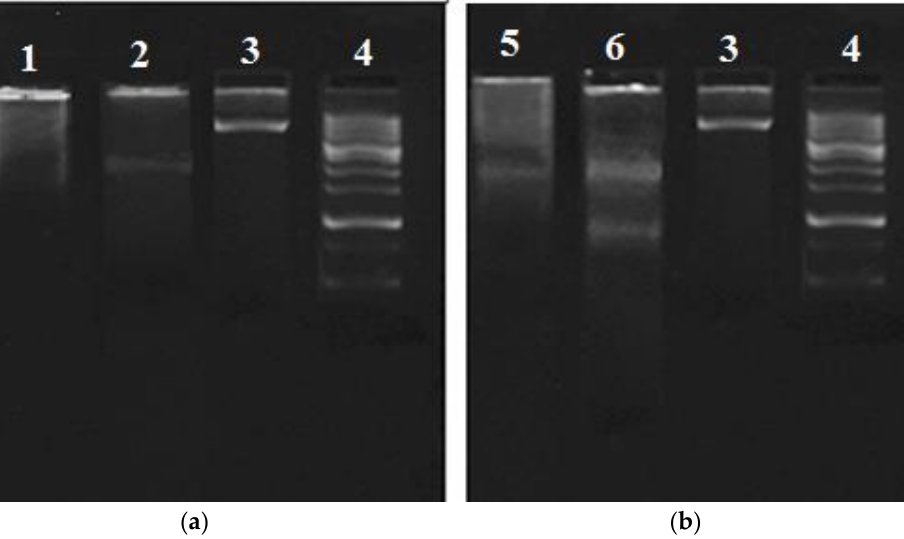
Figure 12. DNA fragmentation shown by agarose gel electrophoresis of MCF-7 ( a ) and RMS cells ( b ) treated with the C. minima hexane fraction (RMS-75 μg/mL, MCF-7 -90 μg/mL) and standard cycloheximide (RMS-30 μg/mL, MCF-7–30 μg/mL); (1) hexane fraction-treated MCF-7 cells; (2): standard cycloheximide-treated MCF-7 cells; (3) control; (4) DNA ladder; (5) hexane fraction-treated RMS cells; 6. standard cycloheximide-treated RMS cells. Concentrations were selected, based on the IC 50 values of cytotoxicity.